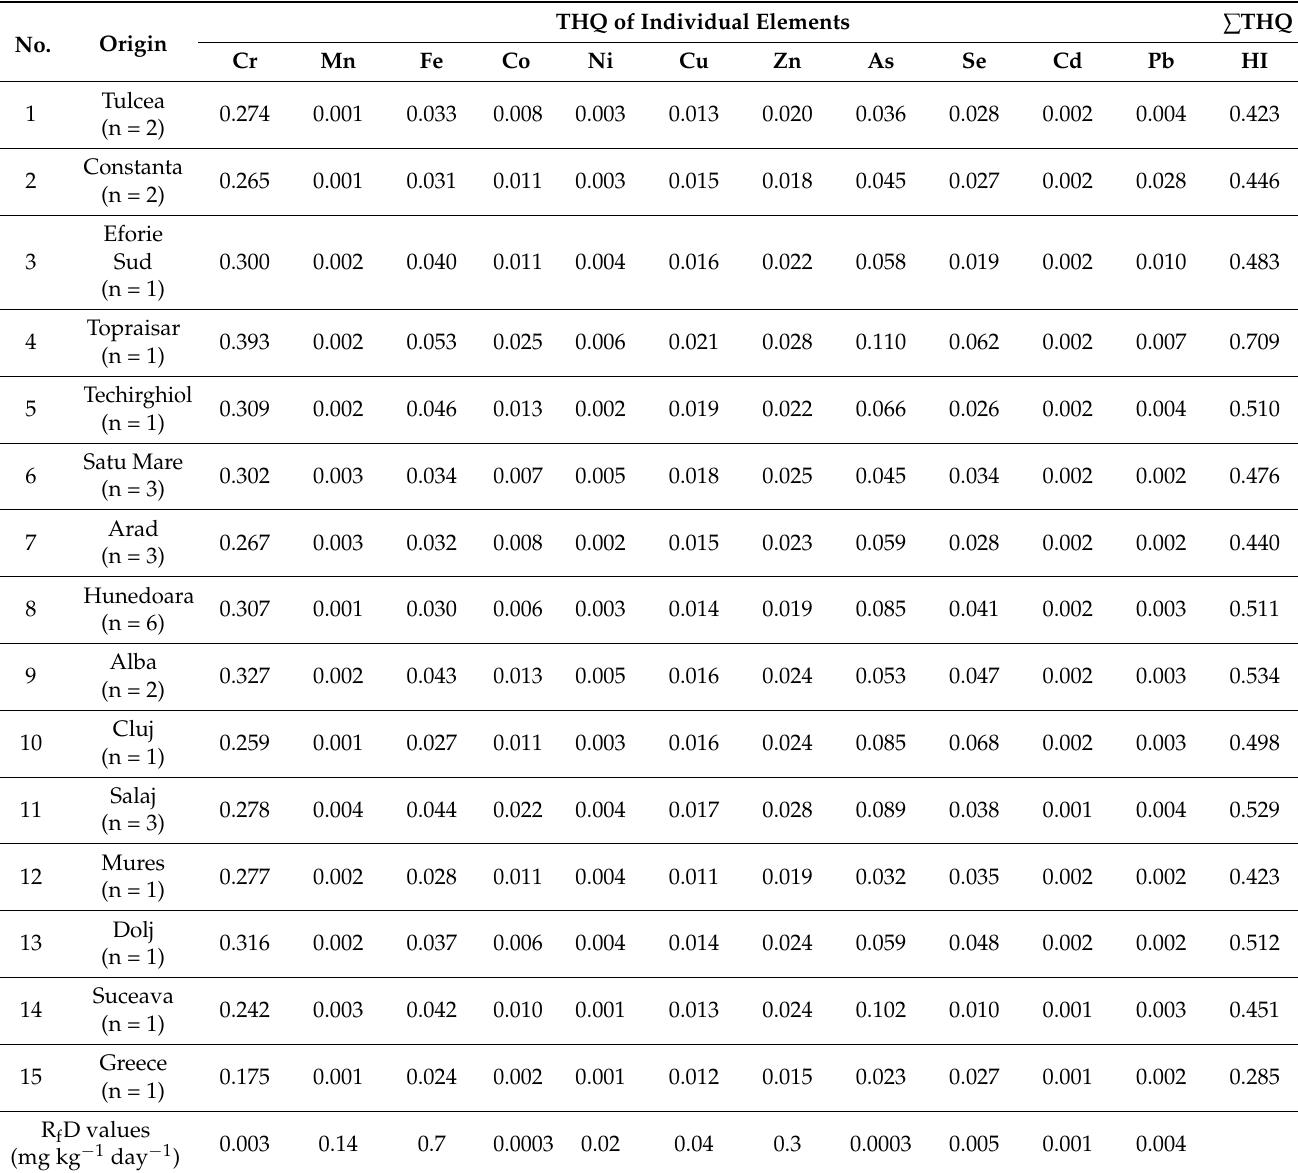
Table 5. Target hazard quotient (THQ) and non-carcinogenic (HI) risk from egg consumption from the study